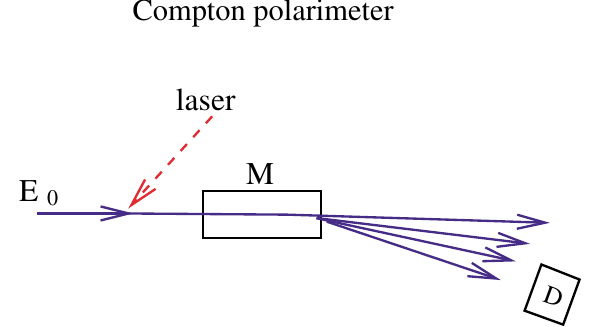
FIG. 3. (Color) Compton polarimeter. M is the analyzing mag- net, D the detector of electrons with large energy